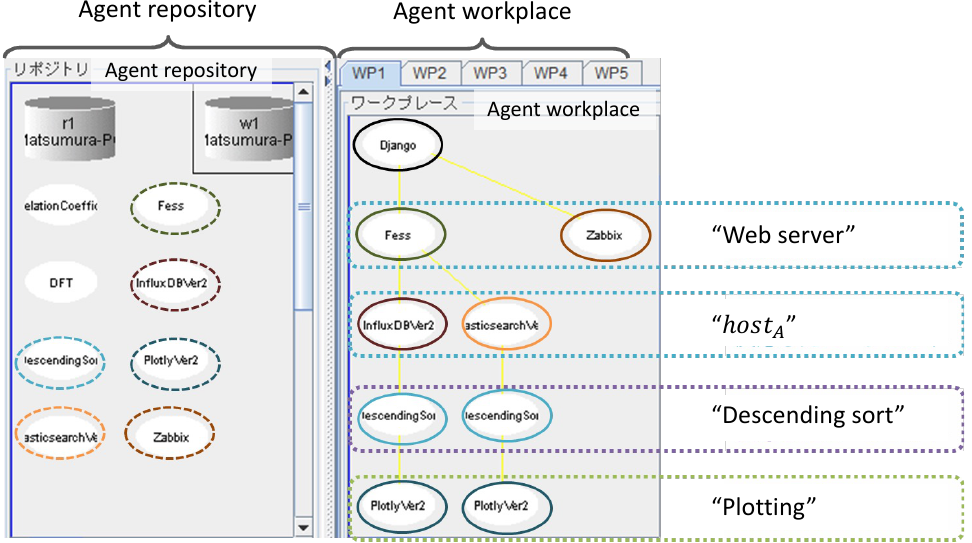
Figure 12. Screenshot of the agent runtime environment (IDEA) when the result of Case 1 was displayed. In this case, six agents were activated from the agent repository and eight active agents organized the three data-processing